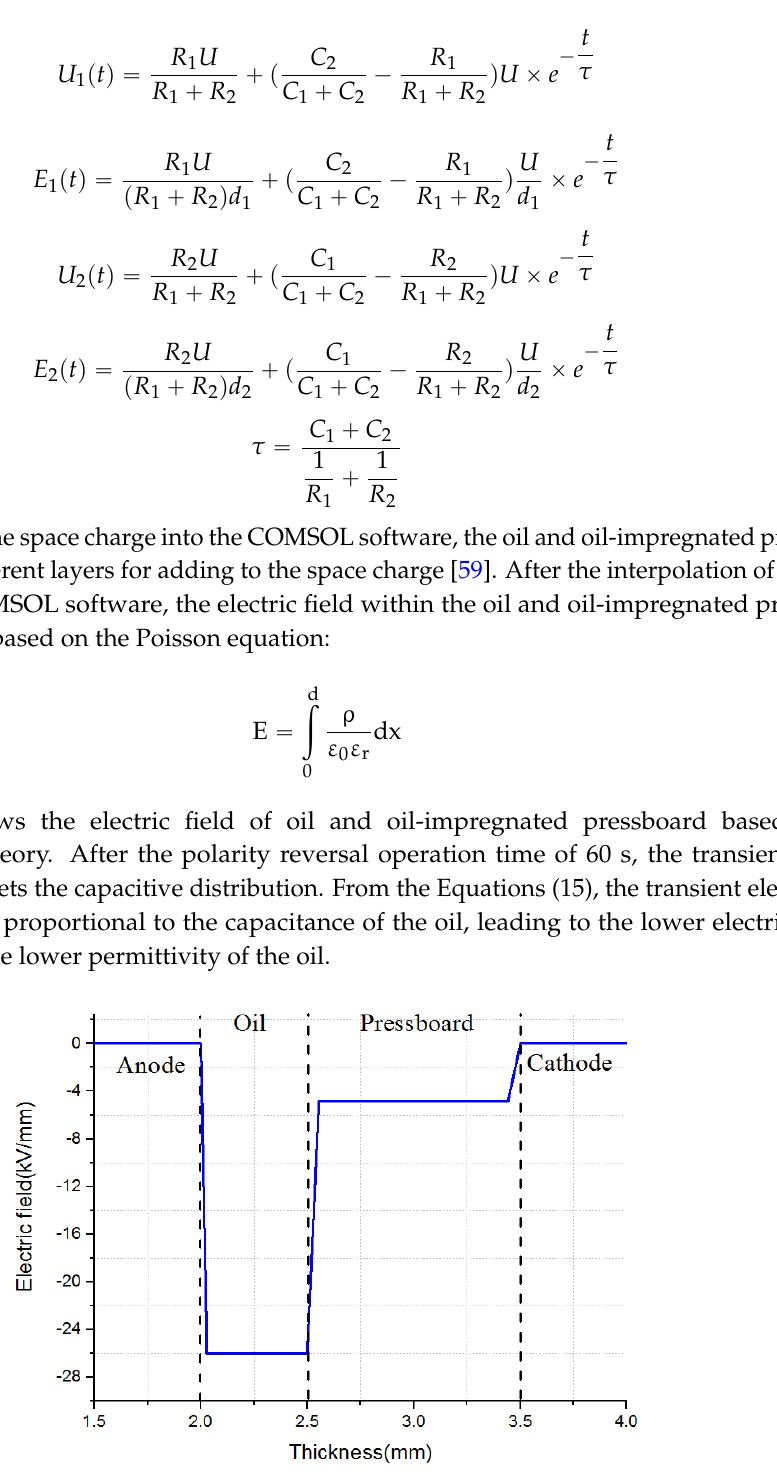
Figure 35. Electric field distribution for fresh oil and oil ‐ impregnated pressboard based on the Maxwell ‐ Wagner theory for polarity reversal operation time of the 60 s.